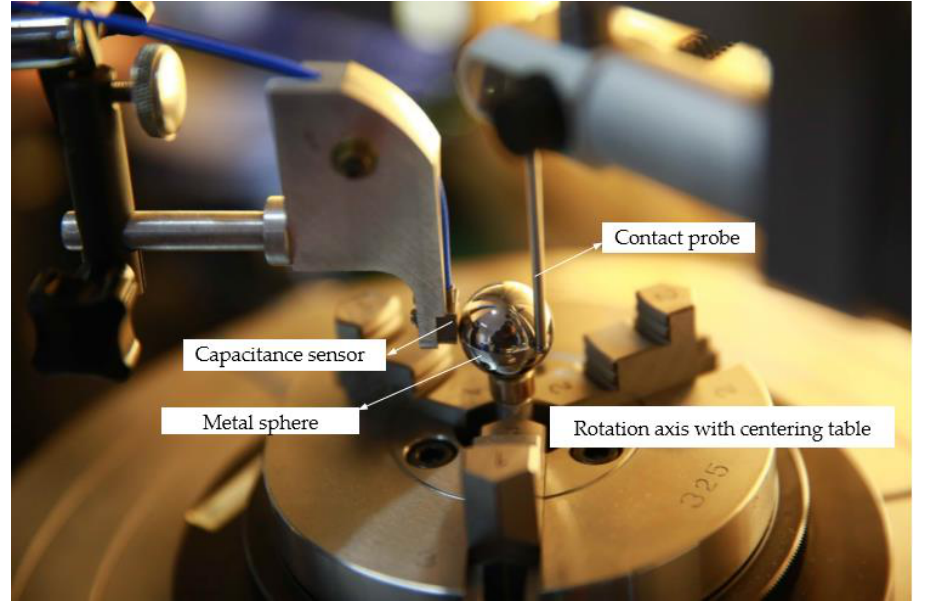
Figure 6. Simultaneous measurement instrument.